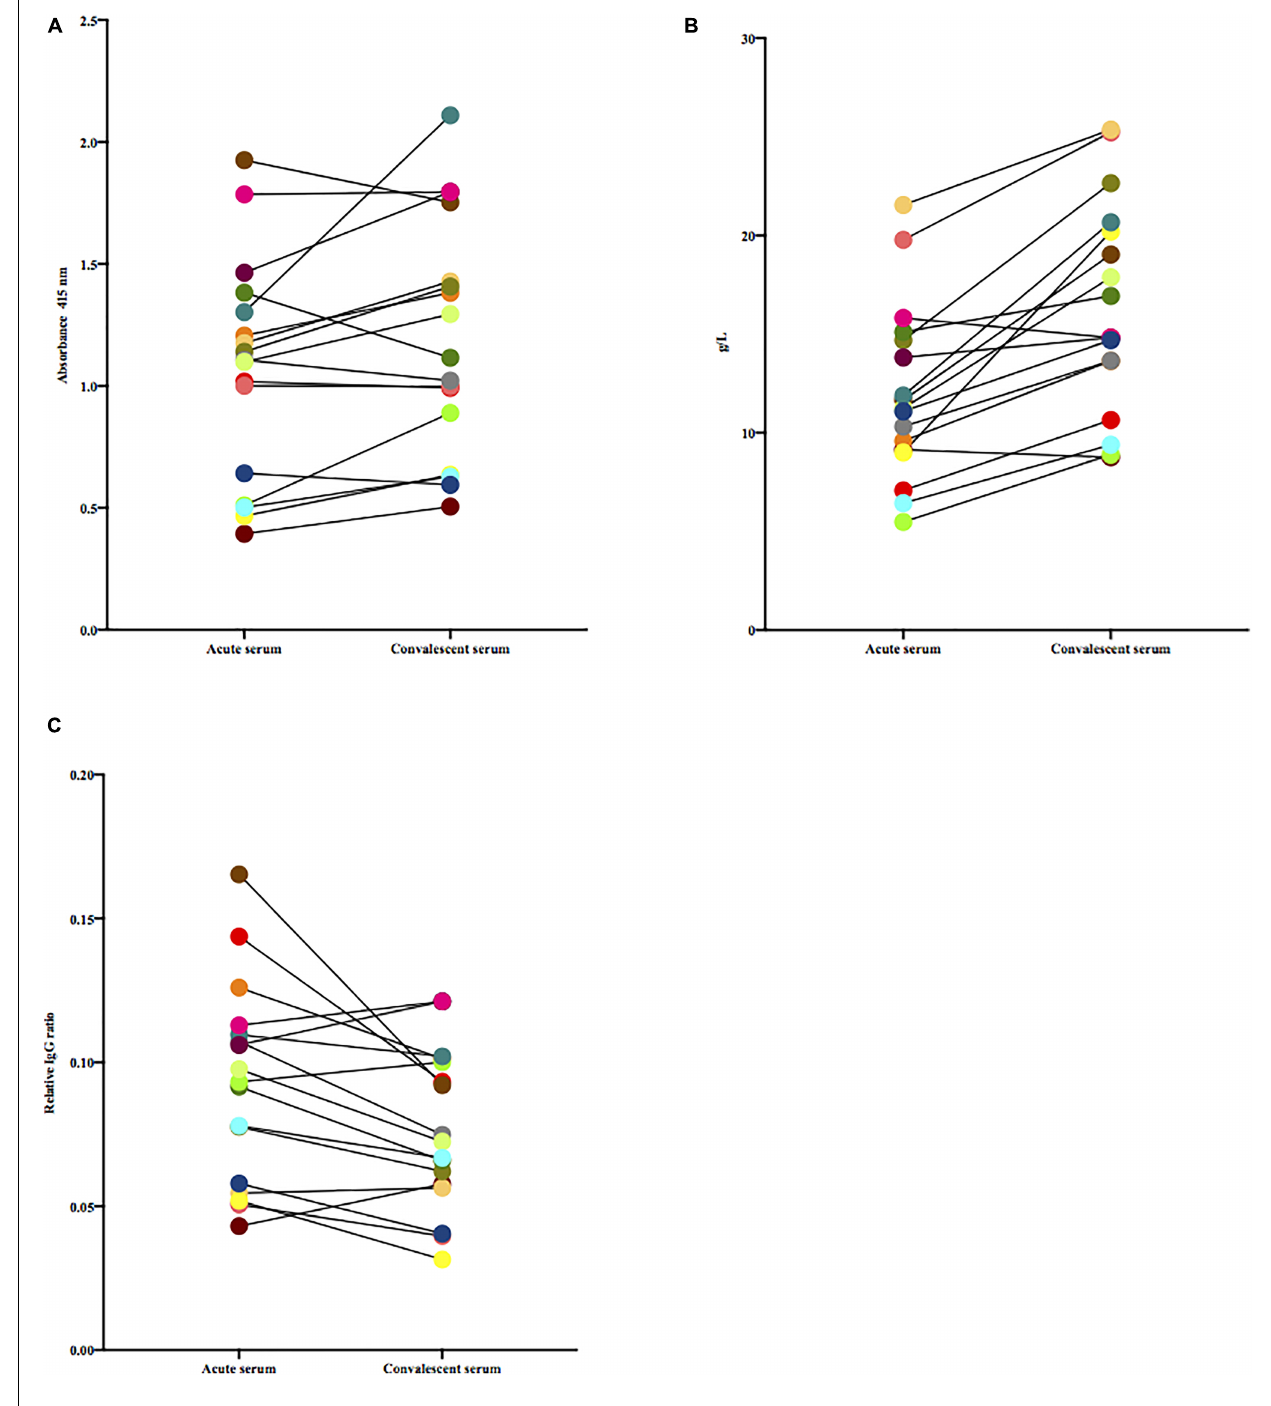
FIGURE 1 | (A) Paired acute and convalescent sera from patients were tested for the presence of antibodies toward G45 (cid:49) proteinG. Wilcoxon matched-pairs signed-rank test was used for comparisons. (B) Total levels of IgG in paired acute and convalescent sera of included patients, quantified by routine clinical procedures, were tested for difference using Wilcoxon matched-pairs signed-rank test. (C) Paired acute and convalescent sera from patients were tested for the presence of antibodies toward G45 (cid:49) proteinG, adjusted for total IgG. Wilcoxon matched-pairs signed-rank test was used to test if difference was statistically